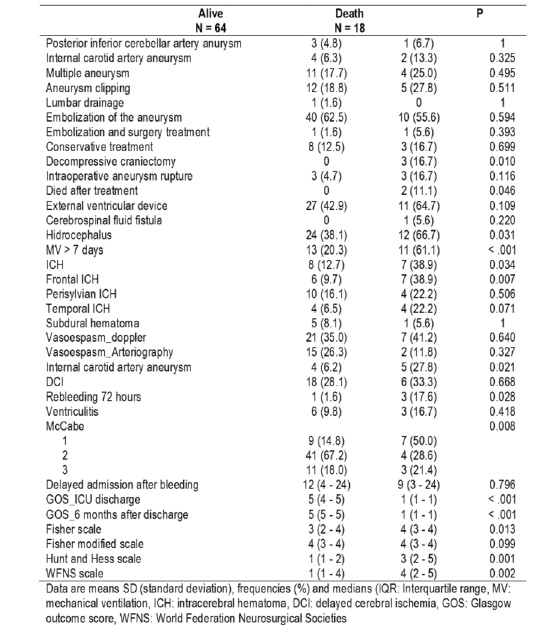
Data are means SD (standard deviation), frequencies (%) and medians (IQR: Interquatile range). SDD selective digestive